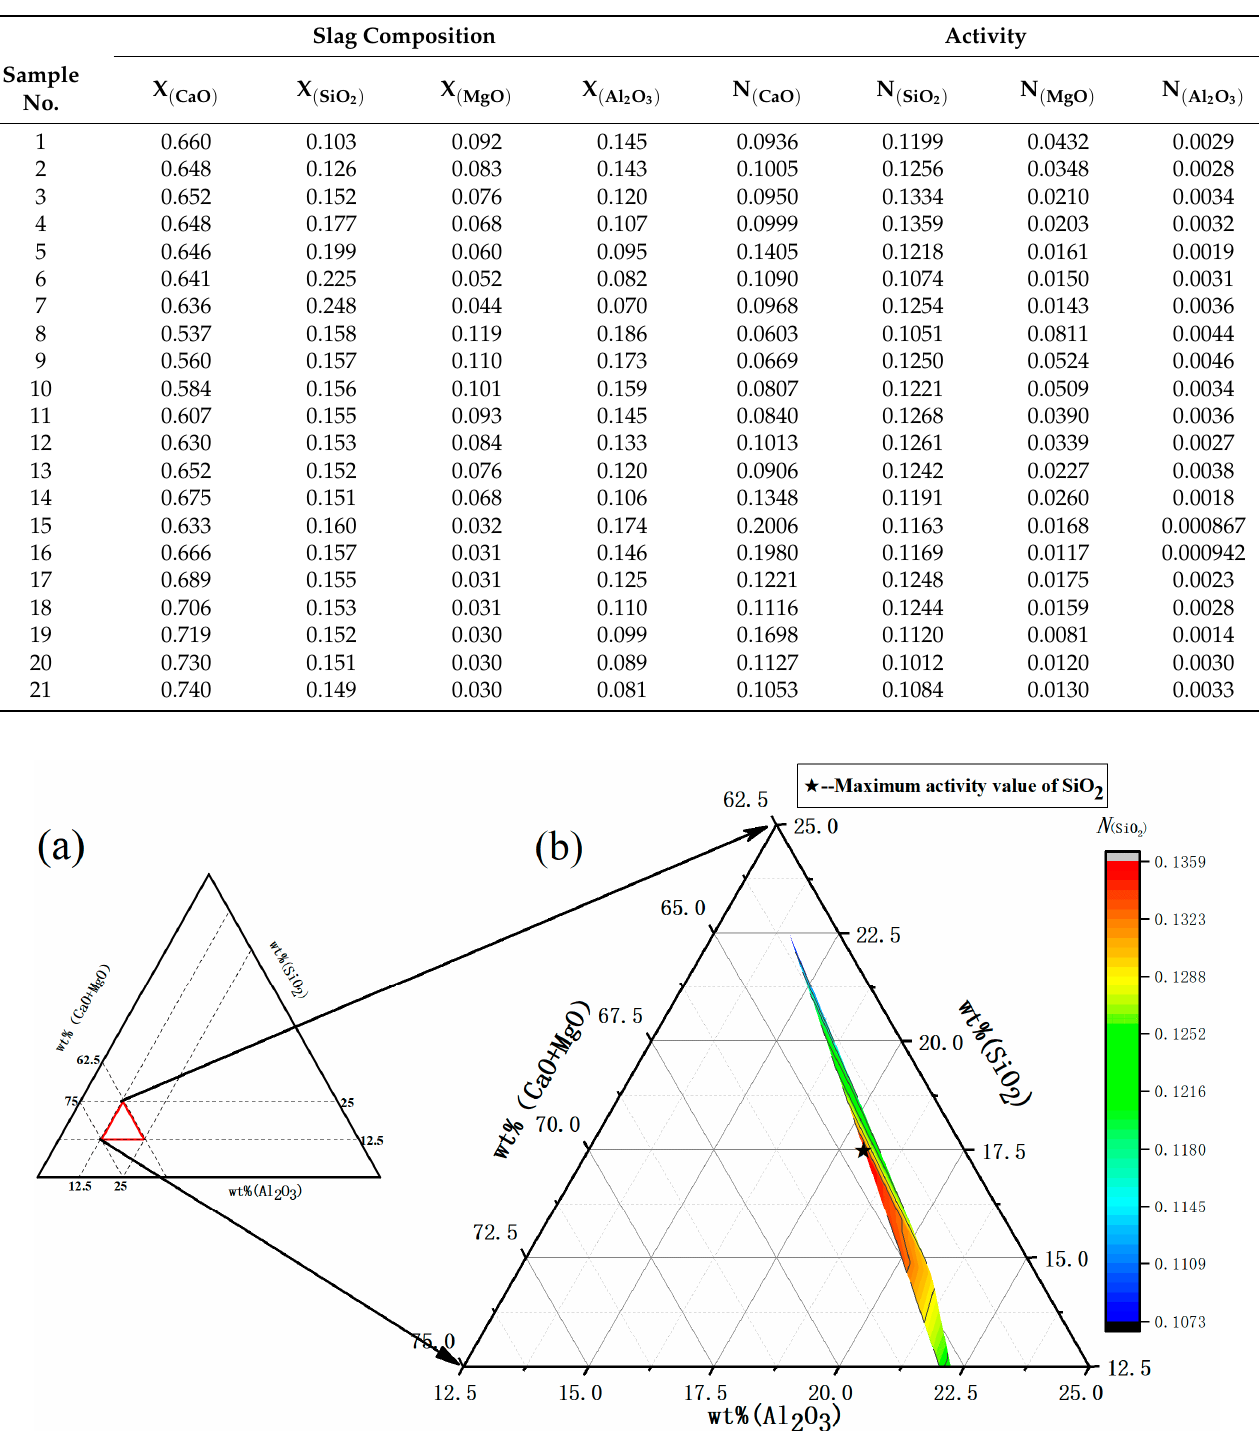
Table 3. Slag composition after equilibrium and the activities of components in the CaO-Al 2 O 3 -SiO 2 - MgO system.